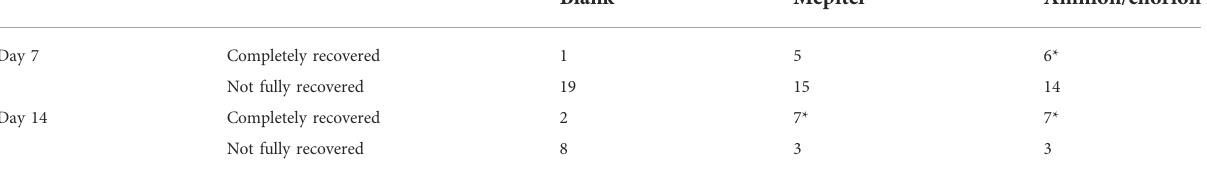
TABLE 5 Number of animals completely